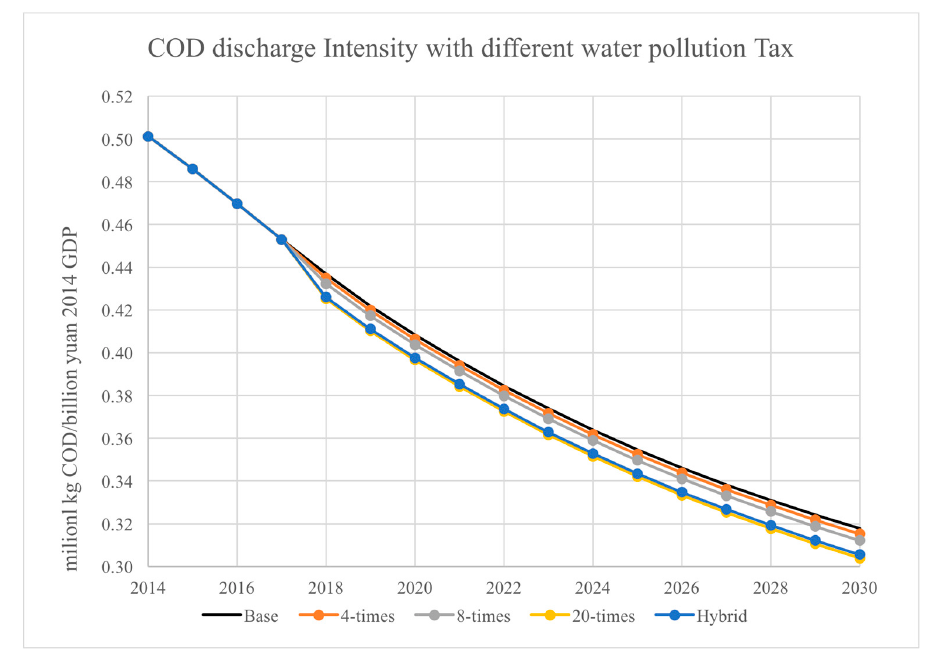
Figure 5. Time path of COD discharge Intensity at different tax levels.